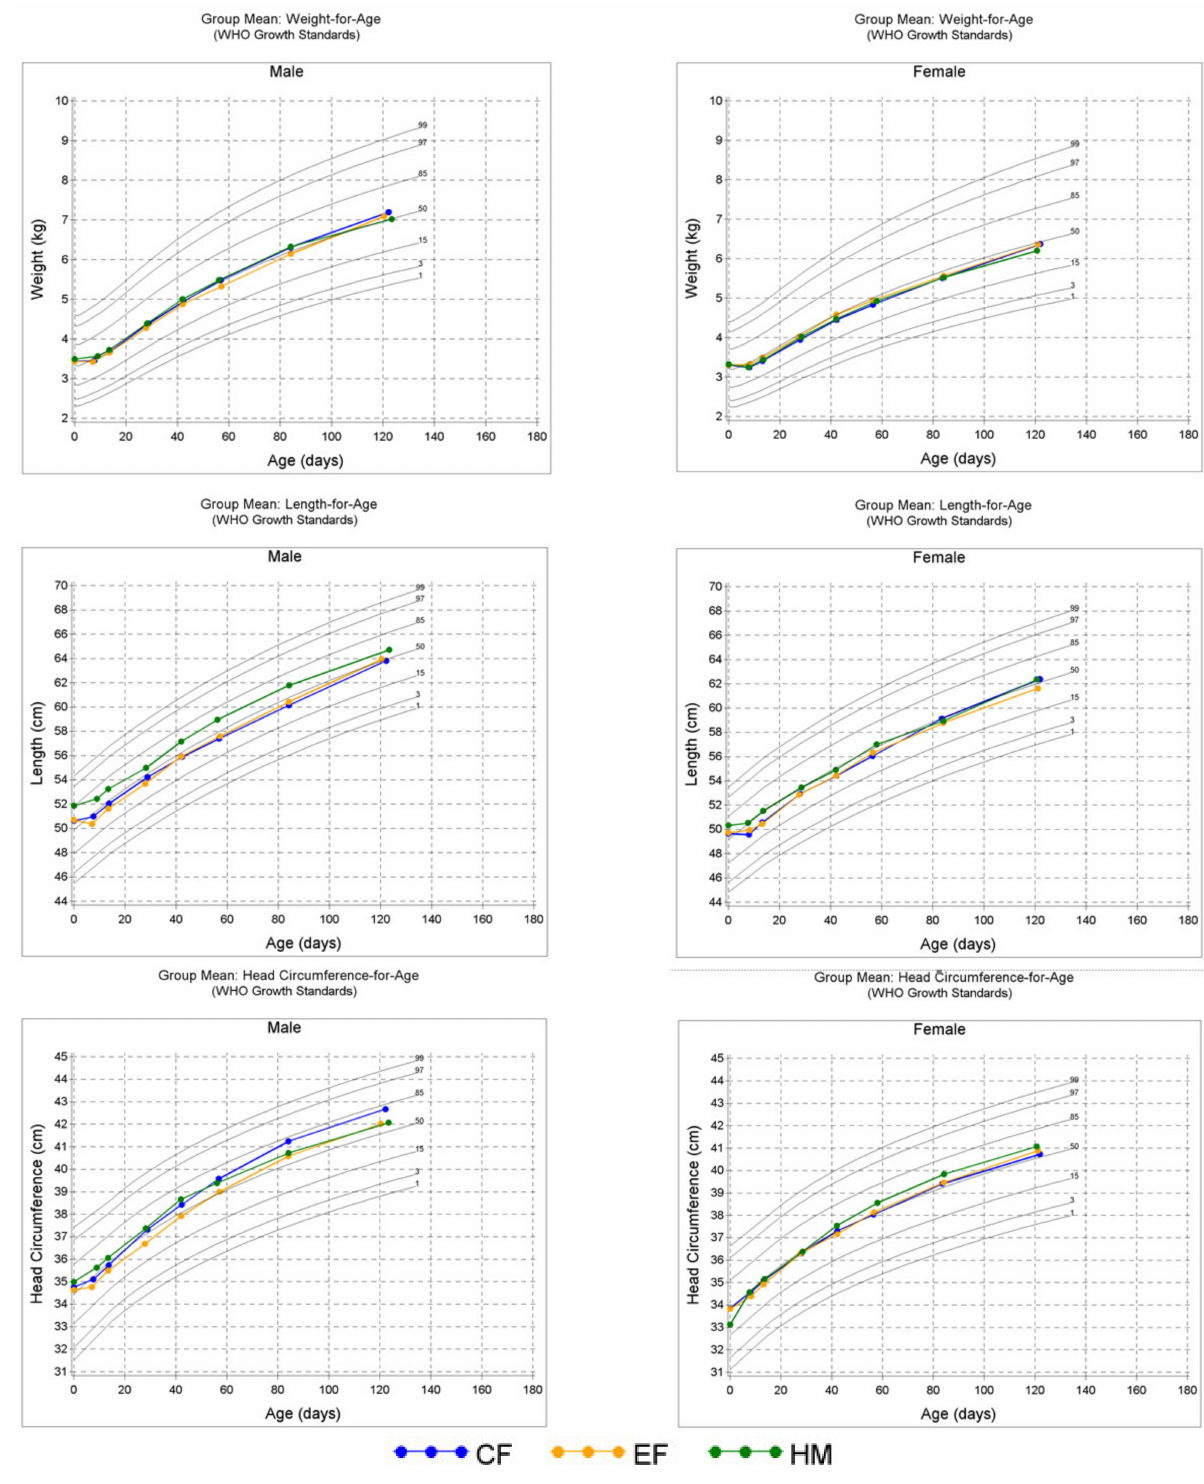
Figure 3. WHO growth charts for protocol evaluable (PE) male and female cohorts in the study; mean weight-for-age, mean length-for-age and mean head circumference-for-age. CF = control formula, EF = experimental formula and HM = human milk reference